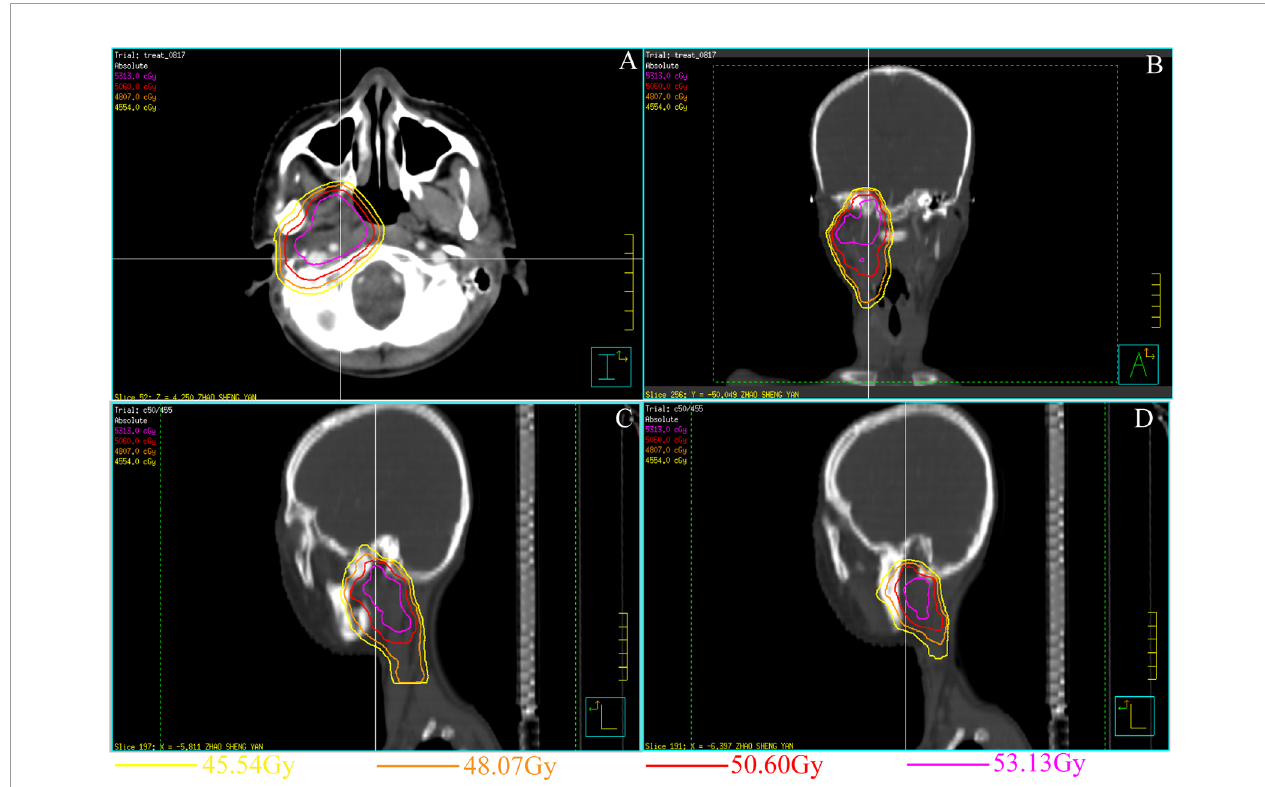
FIGURE 1 | Treatment planning and set-up images for the rhabdomyosarcoma in the right pterygoid muscle 7 years ago (A – D) . (A) Horizontal view CT image of the radiation area. (B) Coronal view CT image of the radiation area. The inner side of the right condylar area was exposed to high-dose radiation. (C, D) Sagittal view CT image of the radiation